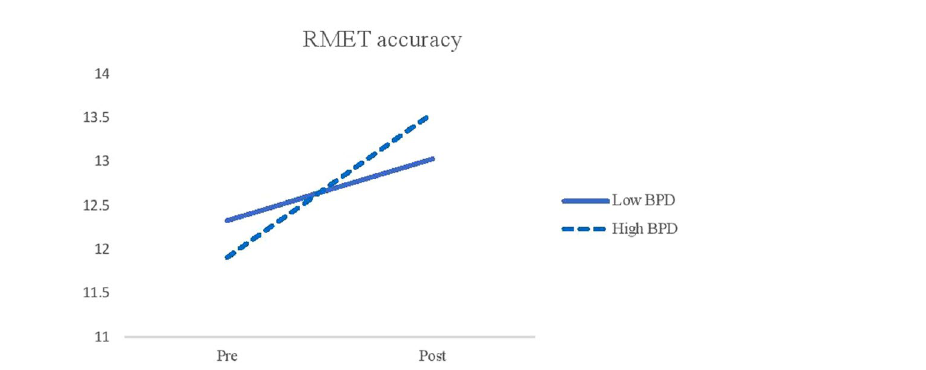
Figure 3. Interaction effects between conditions and the level of BPD features on the emotional Stroop task accuracy. Note . BPD = Borderline Personality Disorder. * p < 0.05 , ** P < 0.01 .